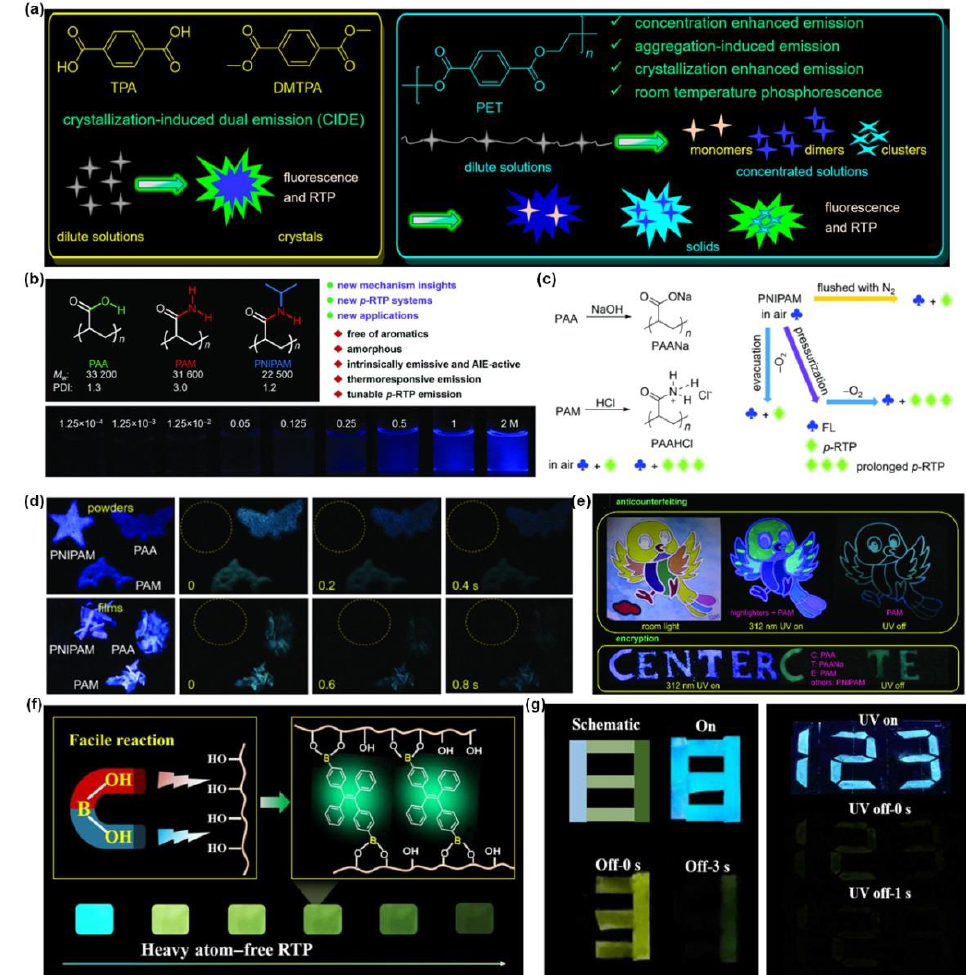
Figure 15. ( a ) The chemical structures of TPA, DMTPA, and PET and the schematic illustration of their emission photophysical properties in different states. Reprinted with the permission from Ref. [99]. 2018, American Chemical Society. ( b ) The chemical structures of PAA, PAM, PNIPAM and photographs of different PNIPAM/DMF solutions under 365 nm UV light. ( c ) Schematic diagram of the modulation of p-RTP properties of different polymers. ( d ) Photographs of different polymer powders taken under or after removing the 312 nm UV irradiation under nitrogen or in vacuum. ( e ) Photographs of practical application in graphic security and information encryption made from different polymers. Reprinted with the permission from Ref. [100]. 2019, Royal Society of Chemistry. ( f ) Schematic illustration of polymer-based RTP through B — O click reaction. ( g )